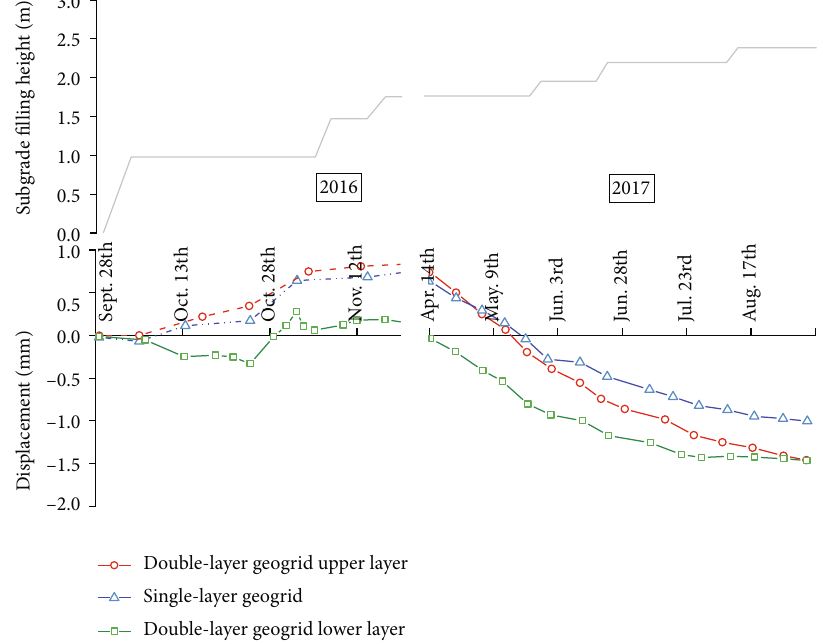
Figure 9: Deformation-time variation curve of the geogrid along the subgrade longitudinal